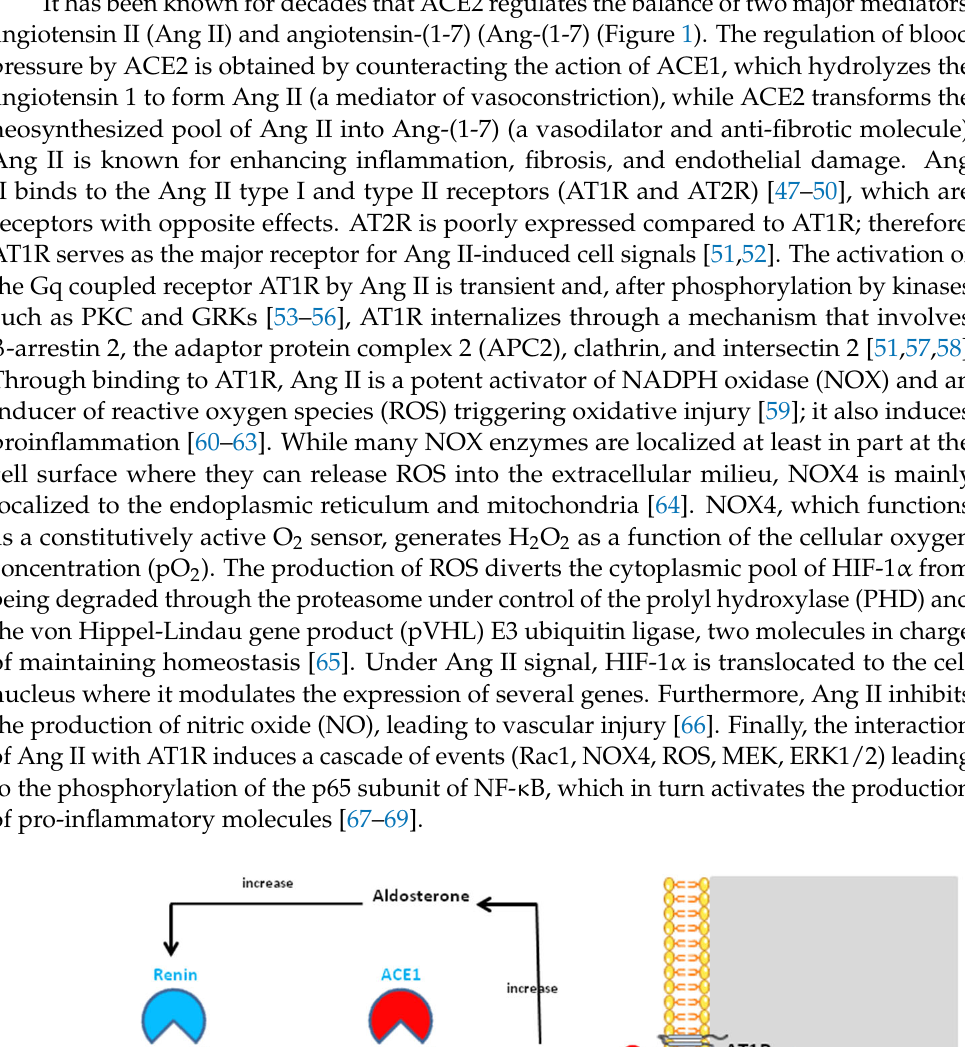
Figure 1. Structure of the renin–angiotensin–(aldosterone) system and the role of ACE2 in this physiological system. ACE1 catalyzes the conversion of angiotensin I (Ang I) to angiotensin II (Ang II). ACE2 catalyzes the conversion of Ang I to angiotensin ‐ (1 ‐ 9) and the conversion of Ang II to an ‐ giotensin ‐ (1 ‐ 7). There are also known interactions between the RAS and the Kinino ‐ gen–(kallikrein)–Bradykinin system (not shown). Under normal physiological conditions, ACE2 converts Ang II into Ang ‐ (1 ‐ 7), which exhibits vasodilatory, anti ‐ proliferative, and an ‐ ti ‐ inflammatory effects via the G protein ‐ coupled receptor called Mas ‐ 1. Ang ‐ (1 ‐ 7) counterbalances the vasoconstrictor and inflammatory effect of Ang II. Upon SARS ‐ CoV ‐ 2 entry, the downregula ‐ tion of ACE2 decreases its ability to generate angiotensin (1 ‐ 9) from Ang I and angiotensin ‐ (1 ‐ 7) from Ang II, leading to renin–angiotensin system (RAS) imbalance and overactivation of the Ang II ‐ AT1R axis. For more details, see reference [70]. Within the molecular cascade devoted to maintaining blood pressure homeostasis, ACE2 is not the unique effector able lead to the production of Ang ‐ (1 ‐ 7). Several pepti ‐ dases, including neprilysin (NEP), vascular endothelium prolyl peptidases, and smooth muscle thimet oligopeptidase, can catalyze the production of Ang ‐ (1 ‐ 7) [71]. Ang ‐ (1 ‐ 7) binds to the G protein ‐ coupled receptor (GPGR) named Mas 1 and is characterized by its vasodilating properties and its anti ‐ proliferative and anti ‐ inflammatory effects [72–74]. The activation of MAS 1 induces nitric oxide synthesis. 4. The RAS Imbalance in COVID ‐ 19 Notably, COVID ‐ 19 has a strong vascular component, with microthrombosis events and exacerbated effects on the microvasculature comprising the arterioles, capillaries, and venules. The RAS imbalance determines the clinical outcome of COVID ‐ 19 [60,75]. The fact that SARS ‐ CoV ‐ 2 enters susceptible human cells by interacting with ACE2 and TMPRSS2 on the surface of lung type II alveolar cells is the central element of the process that leads to RAS imbalance. The down ‐ modulation of ACE2 following its interaction with Sarbecoviruses has been largely documented in vitro [76,77]. The control of ACE2 gene expression is a multifactorial and complex process that has been recently reviewed elsewhere [70]. The binding of SARS ‐ CoV ‐ 2 spike S1 to ACE2 triggers an ACE2 ectodo ‐ main cleavage by the ADAM17 sheddase [78–80]. The ACE2 cleavages induce the shed ‐